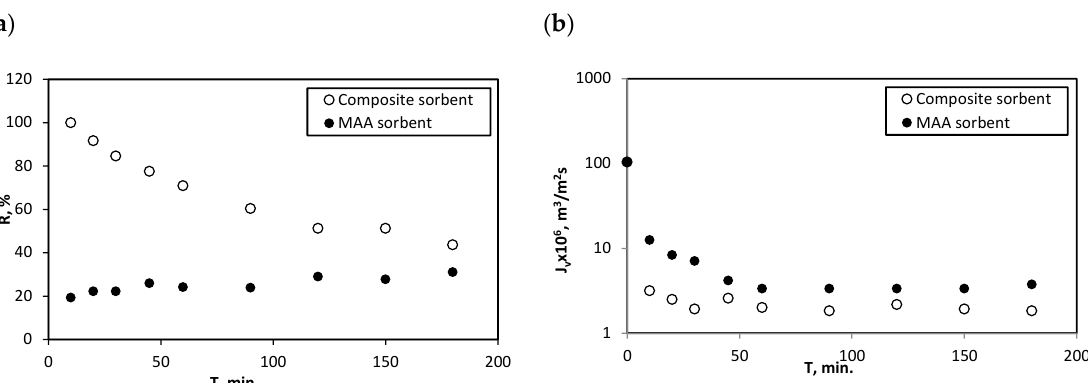
Figure 11. Changes in retention coefficient ( a ) and permeate flux ( b ) during sorption-assisted MF process for two types of MOF sorbents: UiO-66_MAA sorbent and composite sorbent, Csorb. = 1 g/L, T cont. = 60 min.